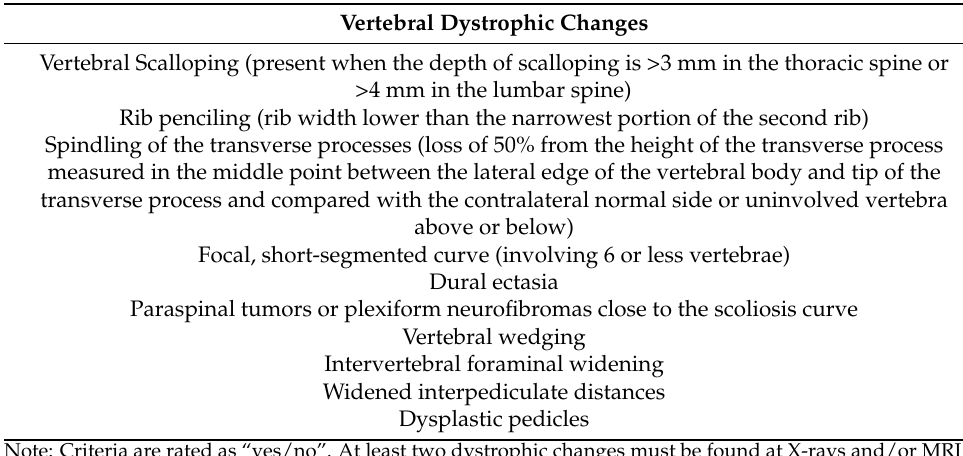
Table 1. Criteria for the definition of a dystrophic scoliosis [6,7,12]. Vertebral Dystrophic Changes Vertebral Scalloping (present when the depth of scalloping is >3 mm in the thoracic spine or >4 mm in the lumbar spine) Rib penciling (rib width lower than the narrowest portion of the second rib) Spindling of the transverse processes (loss of 50% from the height of the transverse process measured in the middle point between the lateral edge of the vertebral body and tip of the transverse process and compared with the contralateral normal side or uninvolved vertebra above or below) Focal, short-segmented curve (involving 6 or less vertebrae) Dural ectasia Paraspinal tumors or plexiform neurofibromas close to the scoliosis curve Vertebral wedging Intervertebral foraminal widening Widened interpediculate distances Dysplastic pedicles